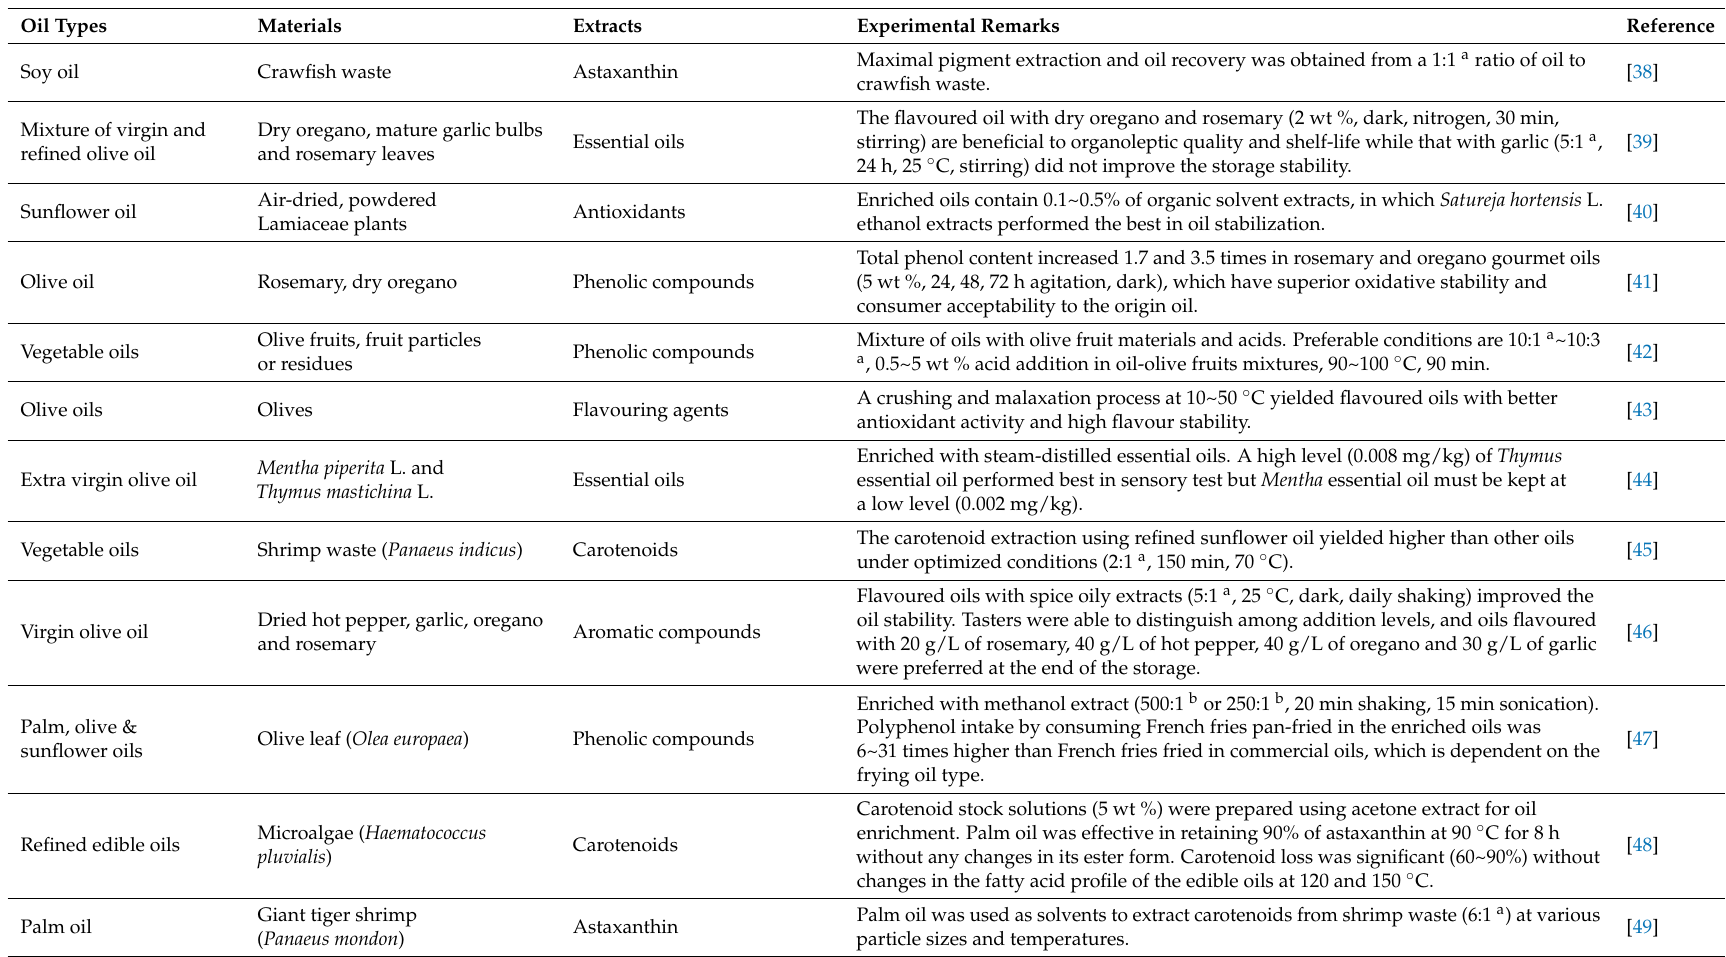
Table 1. Applications of vegetable oils as